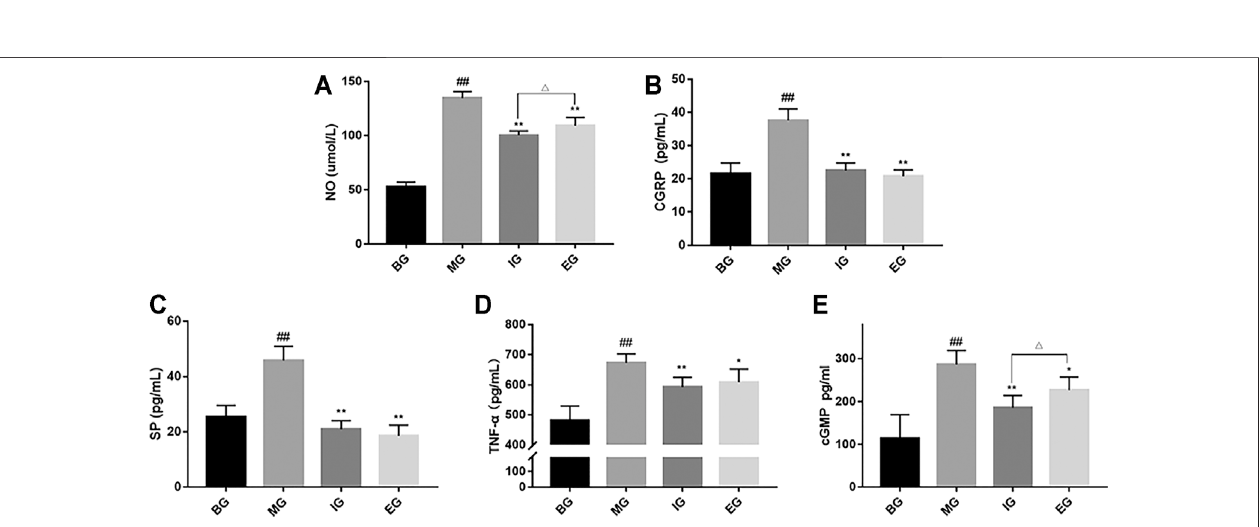
FIGURE 3 | Effect of emodin on vasoactive substances in the serum after NTG treatment. (A) Nitric oxide (NO), (B) Calcitonin gene-related peptide (CGRP), (C) substanceP(SP), (D) TNF- α and (E) cGMP.Datawerepresentedasmean ± SD( n (cid:1) 6), ## p < 0.01comparedwiththeBG;* p < 0.05,** p < 0.01,comparedwiththeMG; Δ p < 0.05, compared with the